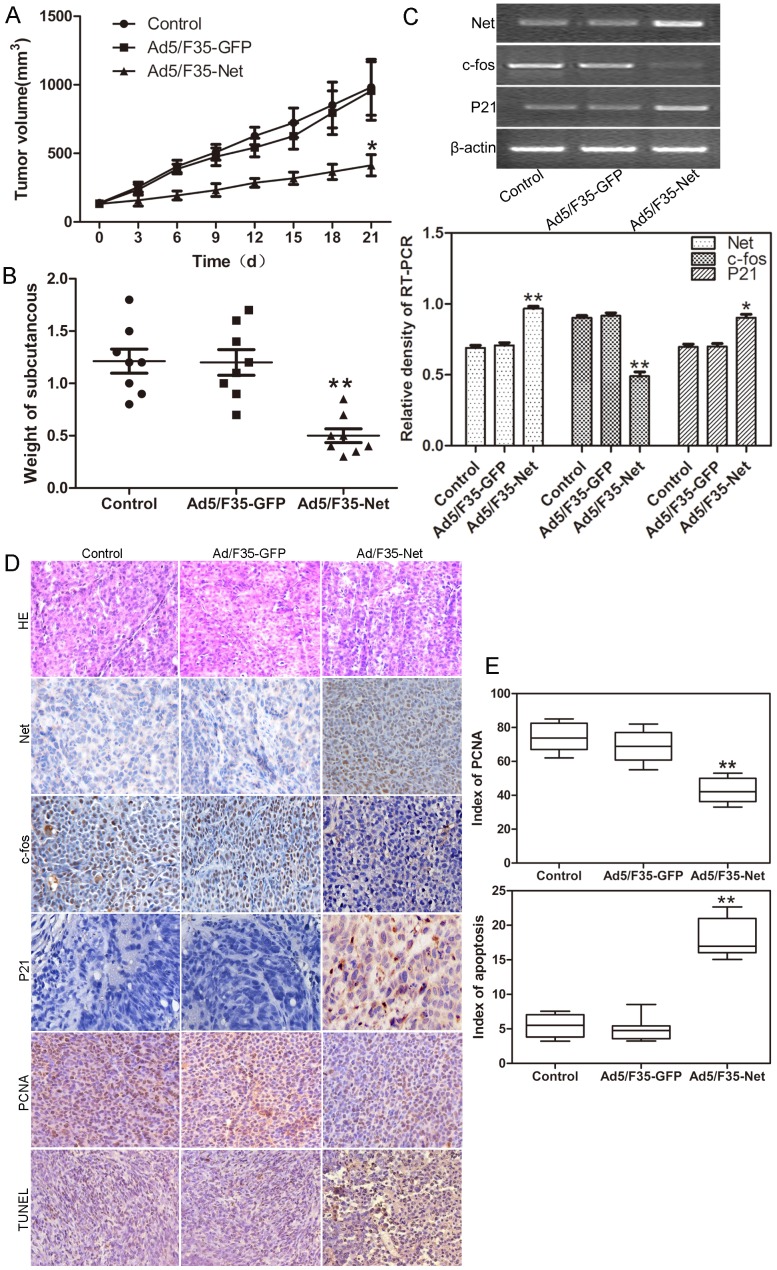
The effects of Net expression on tumor growth in vivo.(A) Tumor size was measured every three days interval in each group. (B) Weight of dissectable xenograft tumors was measured in each group. (C) Expression of Net, c-fos and P21 in mRNA levels in xenograft tissues. (D) Representative H&E staining, histological staining of Net, c-fos and P21, PCNA staining and TUNEL assay in xenogrft tissues. (E) Index of PCNA and apoptosis were accounted in xenograft tumour tissues. *p<0.05, **p<0.01.